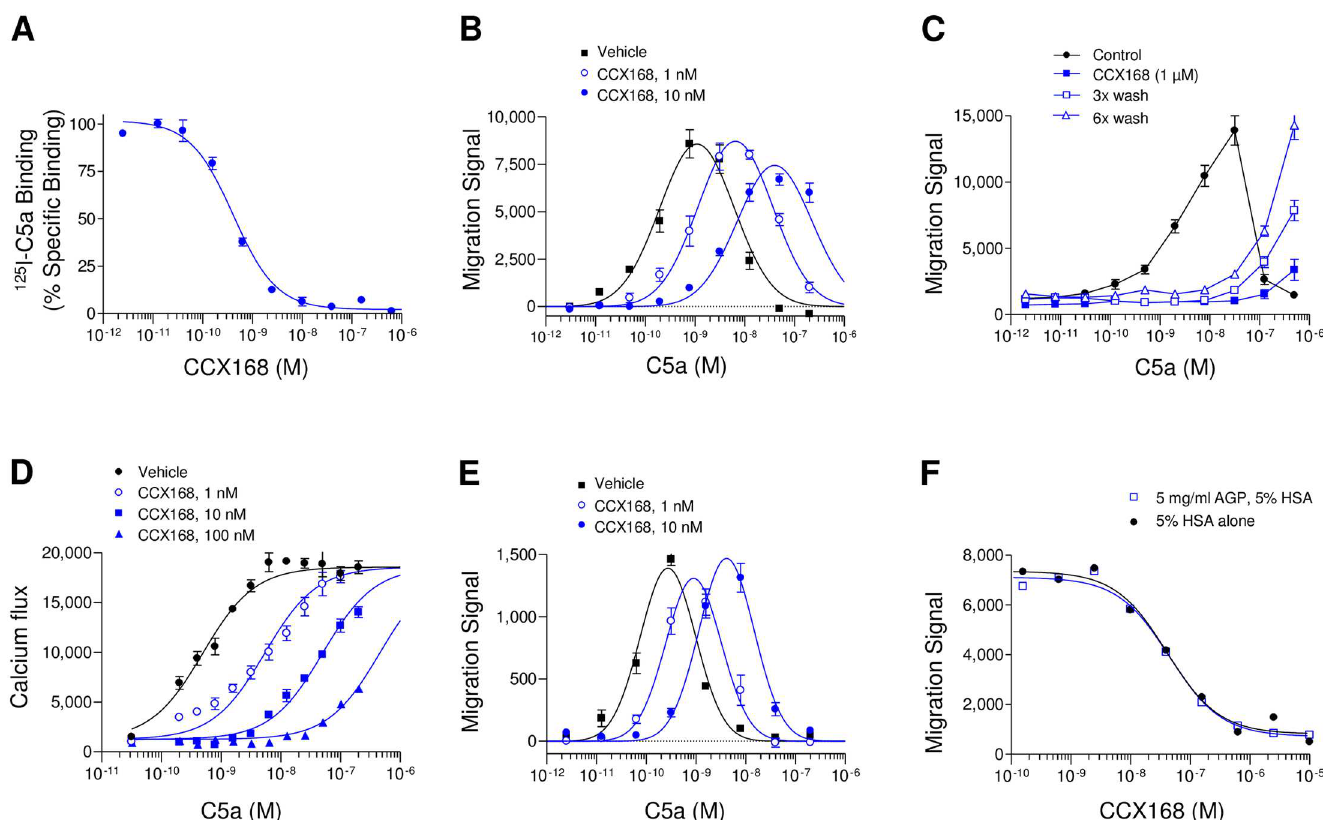
Fig 3. In vitro Characterization of CCX168 Using C5aR-Expressing U937 Cells. (A) CCX168 inhibitionof [ 125 I]-C5a bindingto U937 cells with a potency (IC 50 value) of 0.1 nM; each data point is the mean of 4 replicates ± standard error; study repeated5 separate times, representative experiment shown. (B) Effects of vehicle control ( ■ ) and 1 nM ( (cid:14) ) or 10 nM ( ● ) CCX168 on C5a-mediated chemotaxis of U937 cells in buffer; each data point is the mean of 8 replicates ± standard error; study repeated5 separate times, representative experimentshown. (C) C5a-mediated chemotaxis of U937 cells in the absence ( ● ) or presence ( ■ ) of 1 μ M CCX168, as well as following1 μ M CCX168 / 3x wash ( □ ) and 1 μ M CCX168 / 6x wash ( Δ ) treatments; each data point is the mean of 8 replicates ± standard error; study repeated 2 separate times, representative experiment shown. (D) C5a-induced intracellular calcium release in U937 cells, as measured by FLIPR, in the presence of vehicle control ( ● ) and various concentrations of CCX168, 1 nM ( (cid:14) ), 10 nM ( ■ ), or 100 nM ( ▲ ); each data point is the mean of 4 replicates ± standard error; study repeated 2 separate times, representative experiment shown. (E) C5a- mediated chemotaxis of U937 cells in 100% human plasma in the presence of vehicle control ( ■ ) and 1 nM ( (cid:14) ) or 10 nM ( ● ) CCX168; each data point is the mean of 8 replicates ± standard error; study repeated 2 separate times, representative experimentshown. (F) Inhibitionby CCX168 of U937 cell chemotaxis towards 0.1 nM C5a in the presence ( □ ) or absence ( ● ) of α 1-acid glycoprotein (AGP, 5 mg/mL) in buffer containing 5% human serum albumin (HSA); each data point is the mean of 8 replicates ± standard error; study repeated 2 separate times, representative